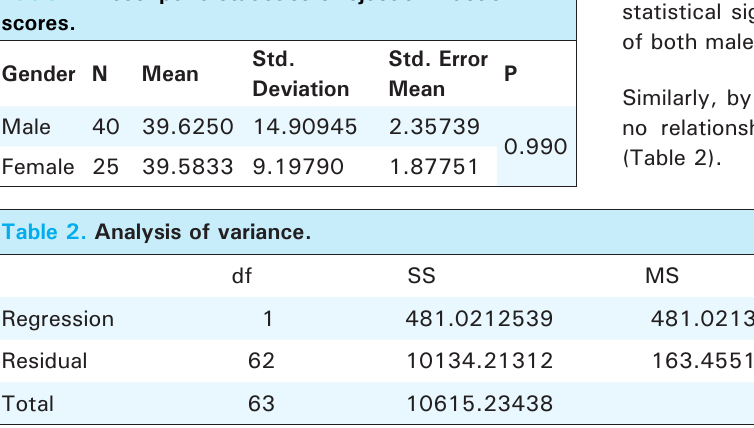
Table 1. Descriptive statistics of ejection fraction scores.